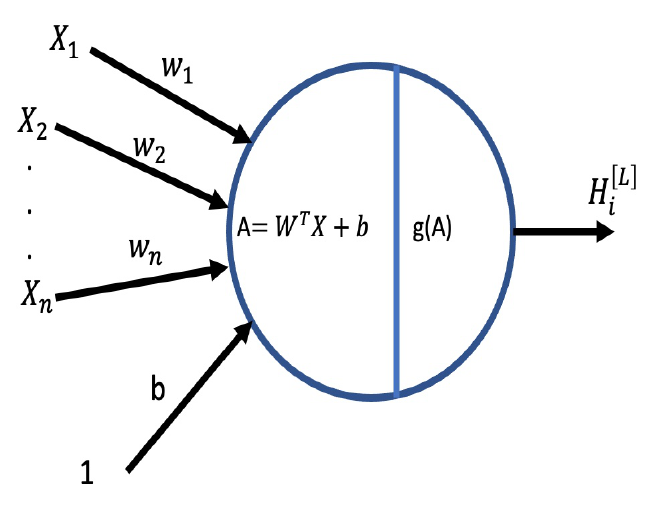
Figure 2. Hidden node in a hidden